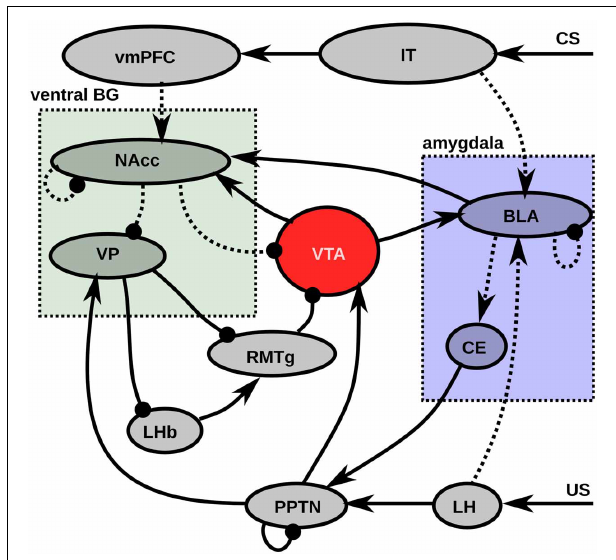
FIGURE 1 | Functional description of the model. Pointed arrows represent excitatory connections, rounded arrows represent inhibitory projections. Dashed lines represent learnable connections, while solid represent fixed connections. LH signals US delivery to BLA (Sah et al., 2003) and PPTN (Semba and Fibiger, 1992). IT encode a visual representation of the CS, which activates BLA (Cheng et al., 1997) and vmPFC (Carmichael and Price, 1995). BLA learns to associates the CS and US representations under the modulatory influence of the DA released by VTA (Bissière et al., 2003) and projects on CE (LeDoux, 2000) which excites PPTN (Semba and Fibiger, 1992). The excitatory projection from PPTN to VTA is able to provoke phasic DA bursts (Lokwan et al., 1999). NAcc MSN neurons receives excitatory projections from BLA (Ambroggi et al., 2008) and vmPFC (Haber, 2003) and learning is modulated by DA release from VTA (Robbins and Everitt, 1996). They inhibit VTA dopaminergic neurons (Usuda et al., 1998) and VP (Zahm and Heimer, 1990). VP also receives excitatory projections from PPTN (Hallanger and Wainer, 1988) and